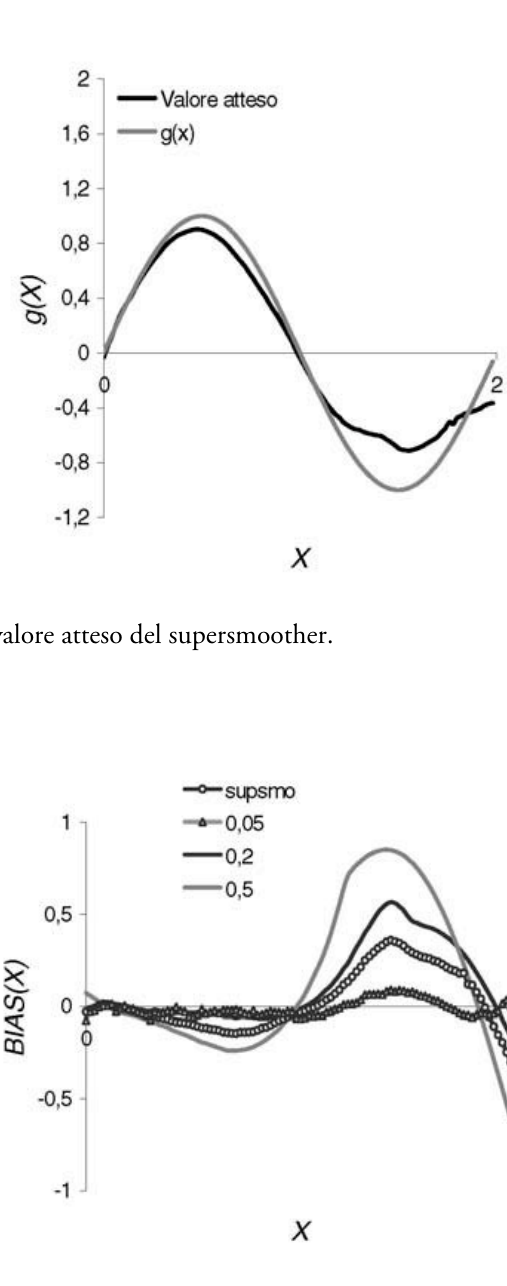
Figura 6 – Modello II: distorsione degli